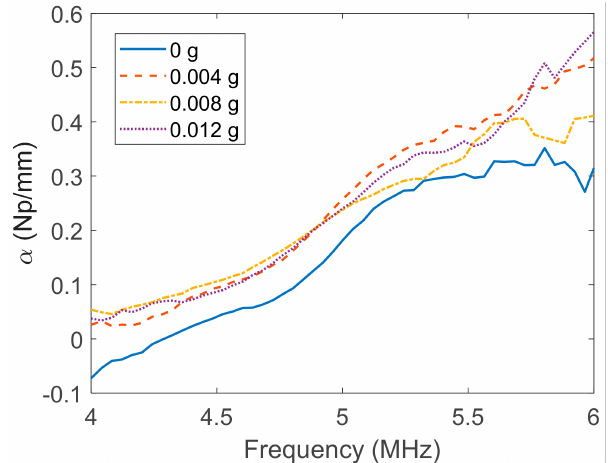
Figure 8. Coherent wave attenuation over the excitation frequency